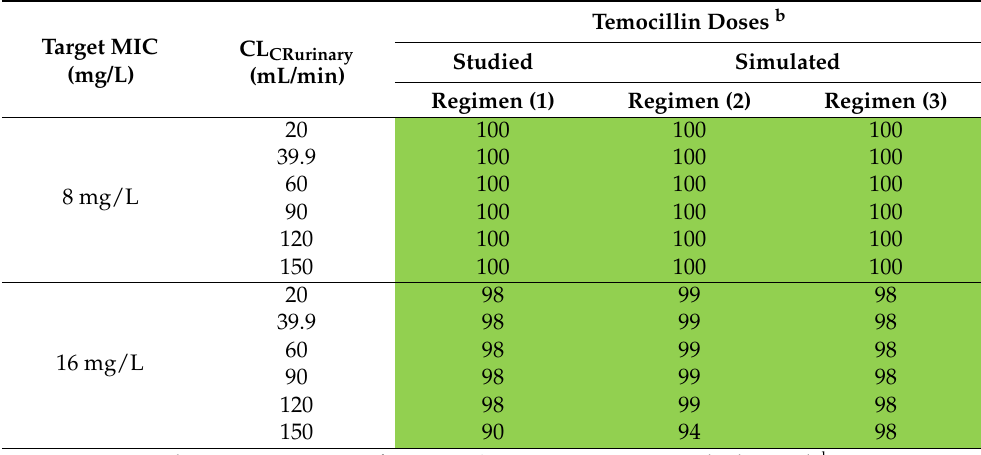
Table 5. Probability of target attainment (PTA) a (in percentages) in plasma between 0 to 96 h for the various temocillin dosing regimens according to the CL CRurinary values for a target MIC of 8 and 16 mg/L.